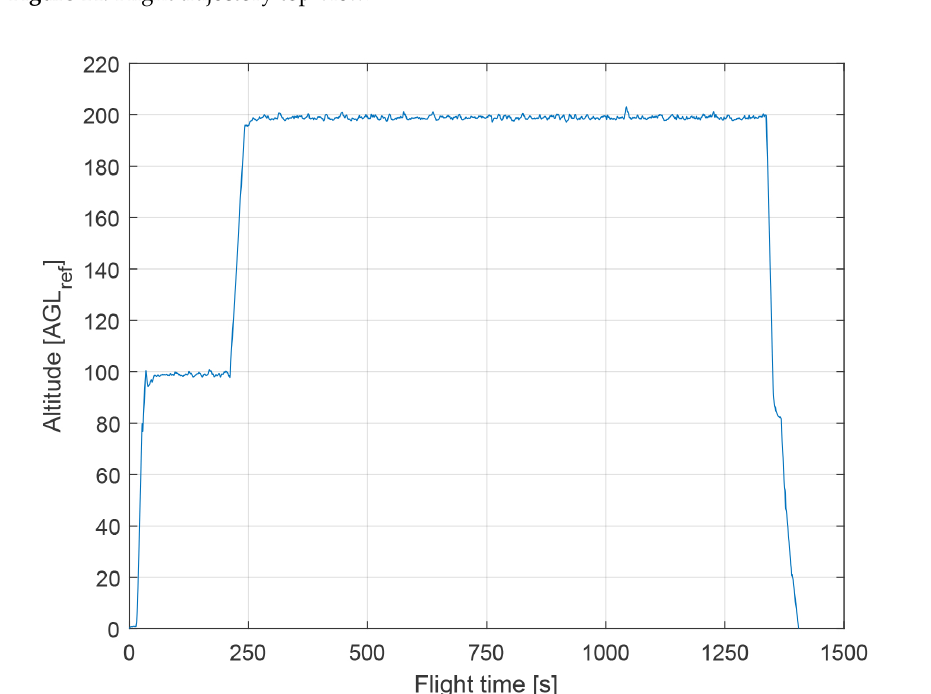
Figure 15. Altitude above ground level in respect to the reference point as a function of simula- tion